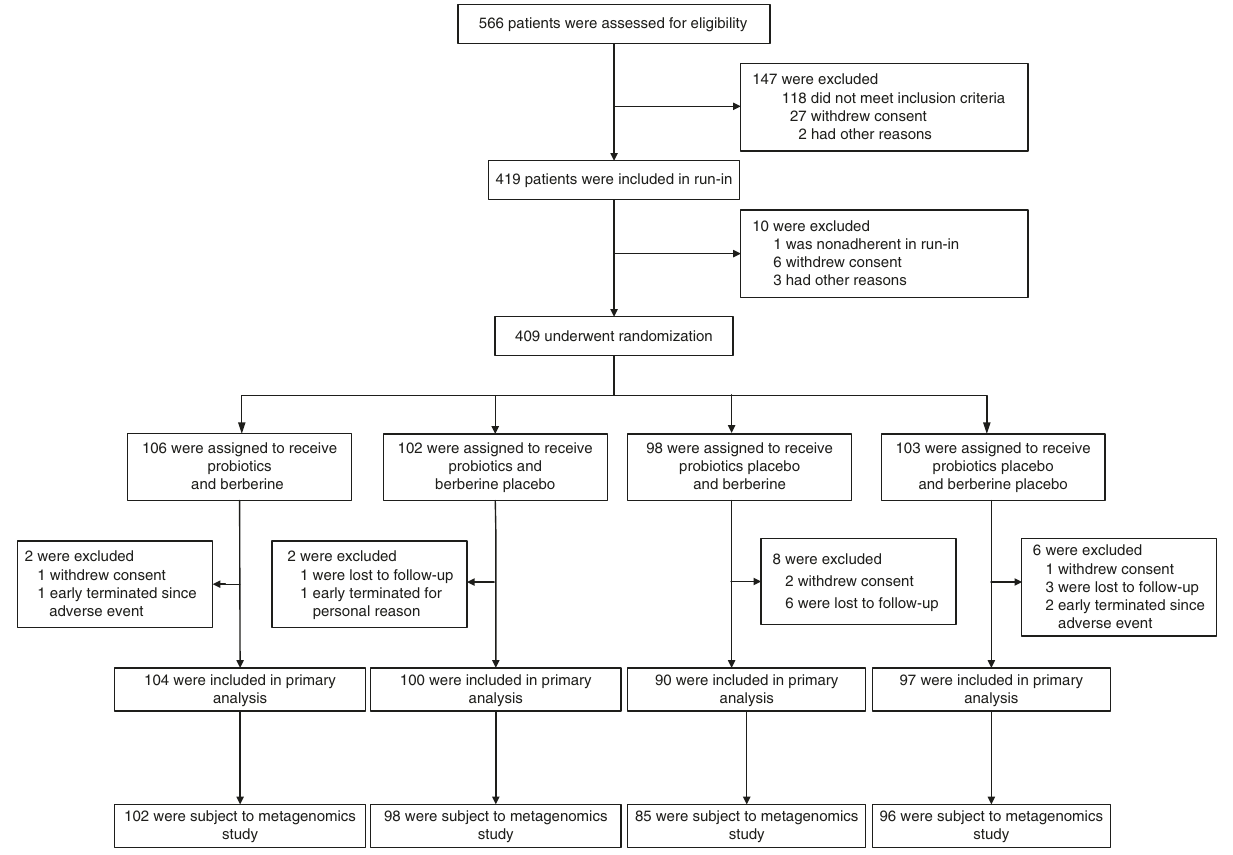
Fig. 1 Flow diagram of participant enrolment in the PREMOTE Trial.